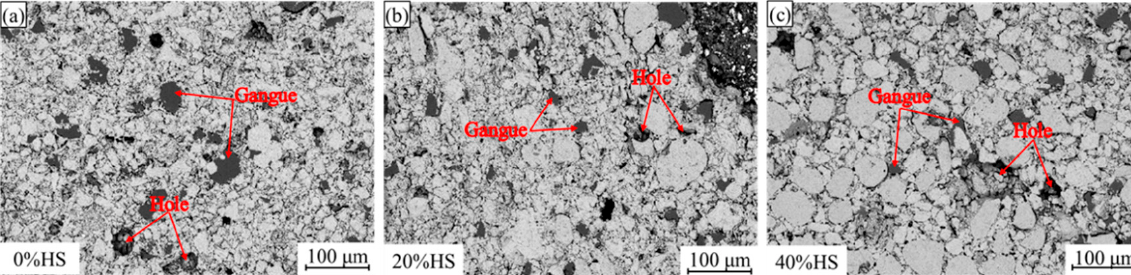
Figure 7. SEM diagrams of oxidized pellets with different the dosage of sea sand ore.